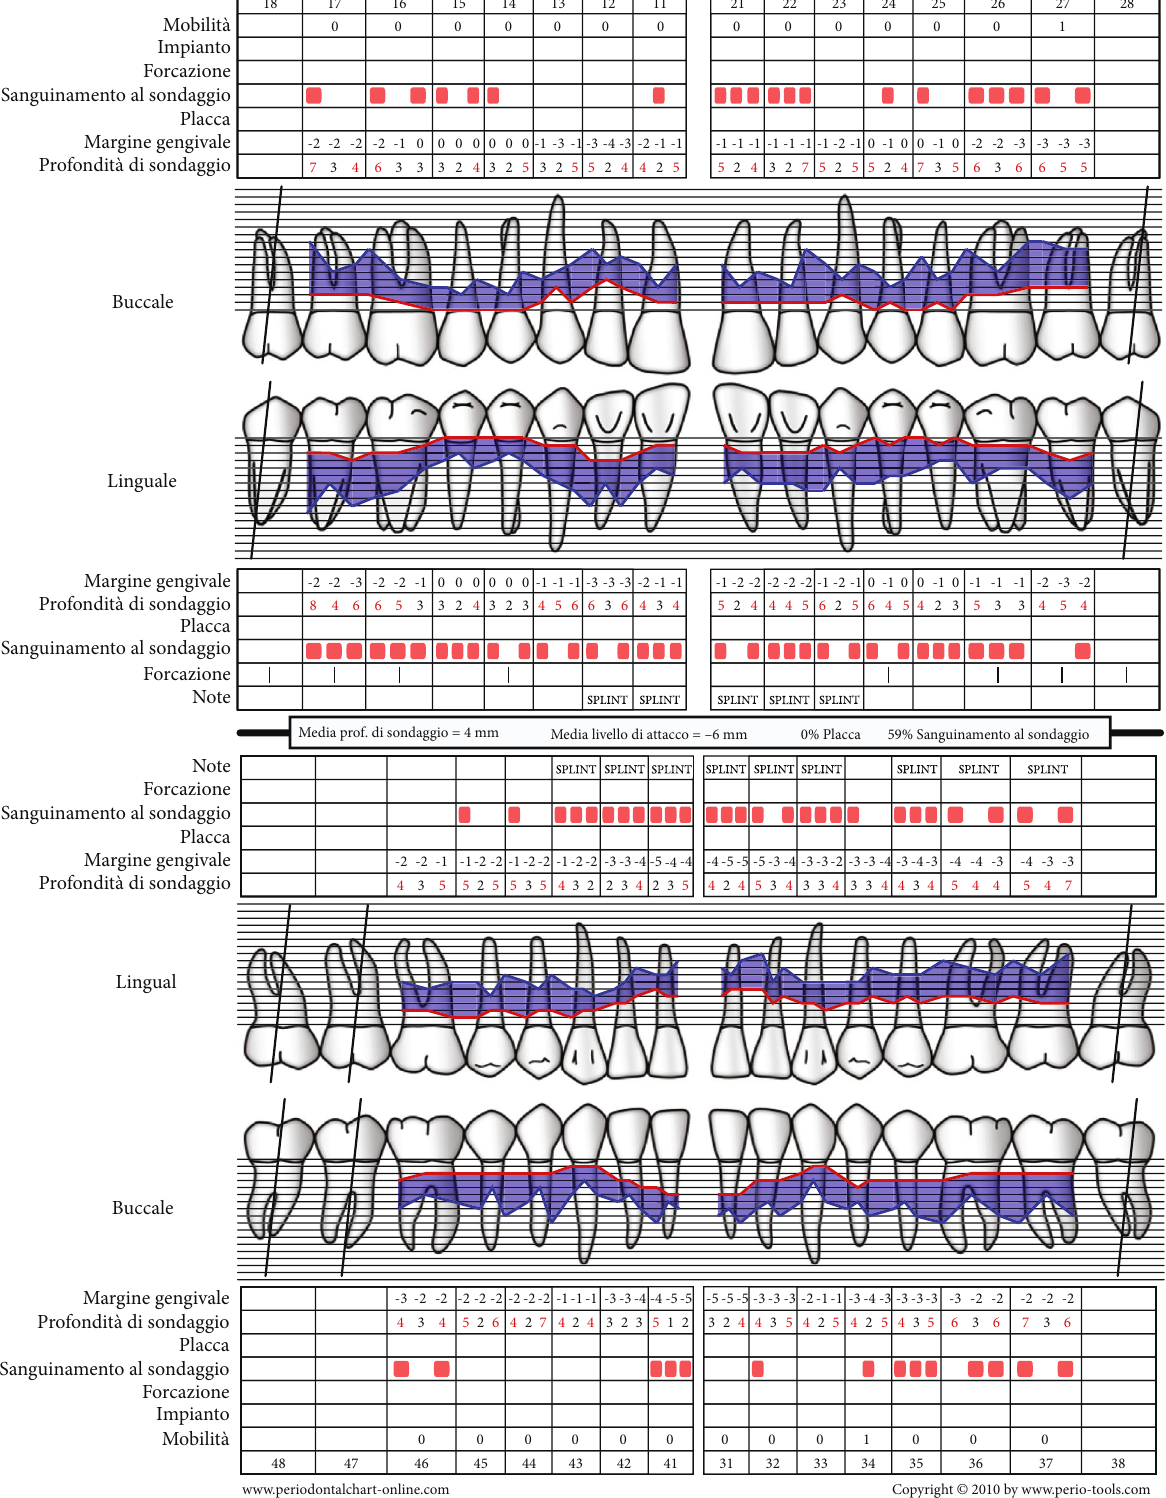
Figure 5: Probing with periodontal